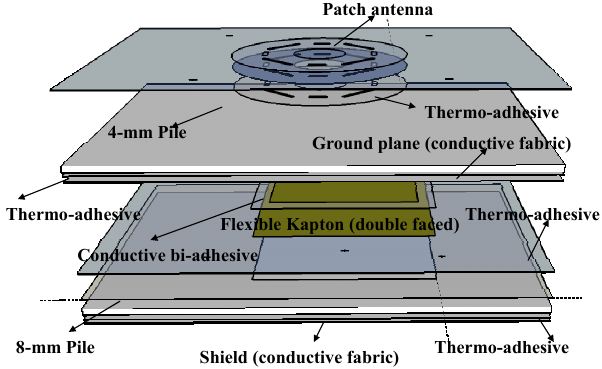
Figure 4. Stack-up of the proposed tri-band wearable rectenna.